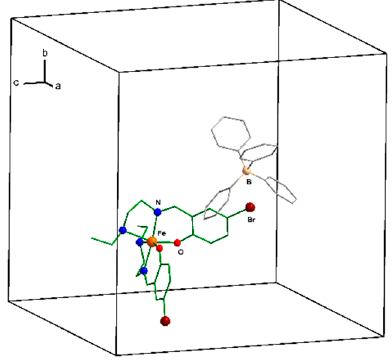
Figure 2. Supercell model of the ion pair [Fe(5-Br-salEen) 2 ]BPh 4 in the LS state.